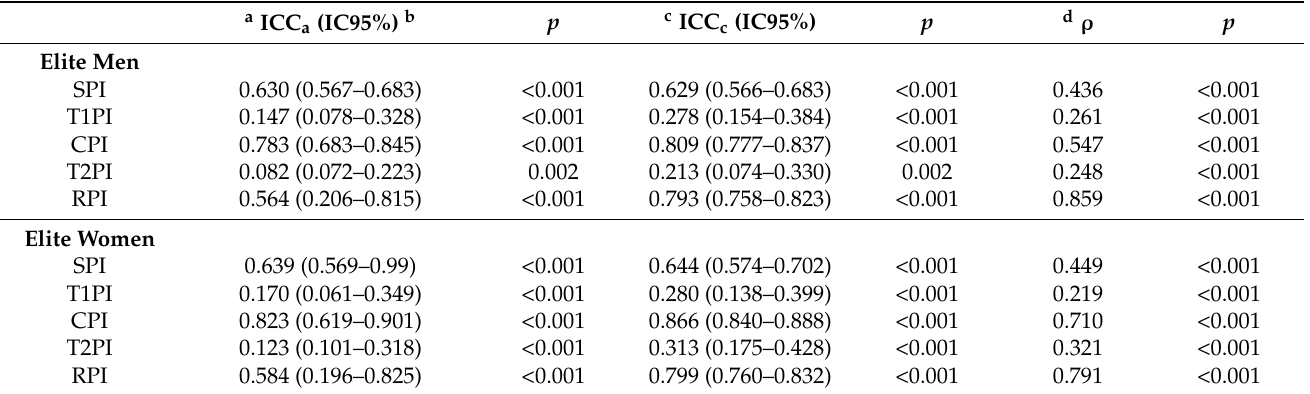
Table 1. Random selection of the subsample representing 10% of the total sample.